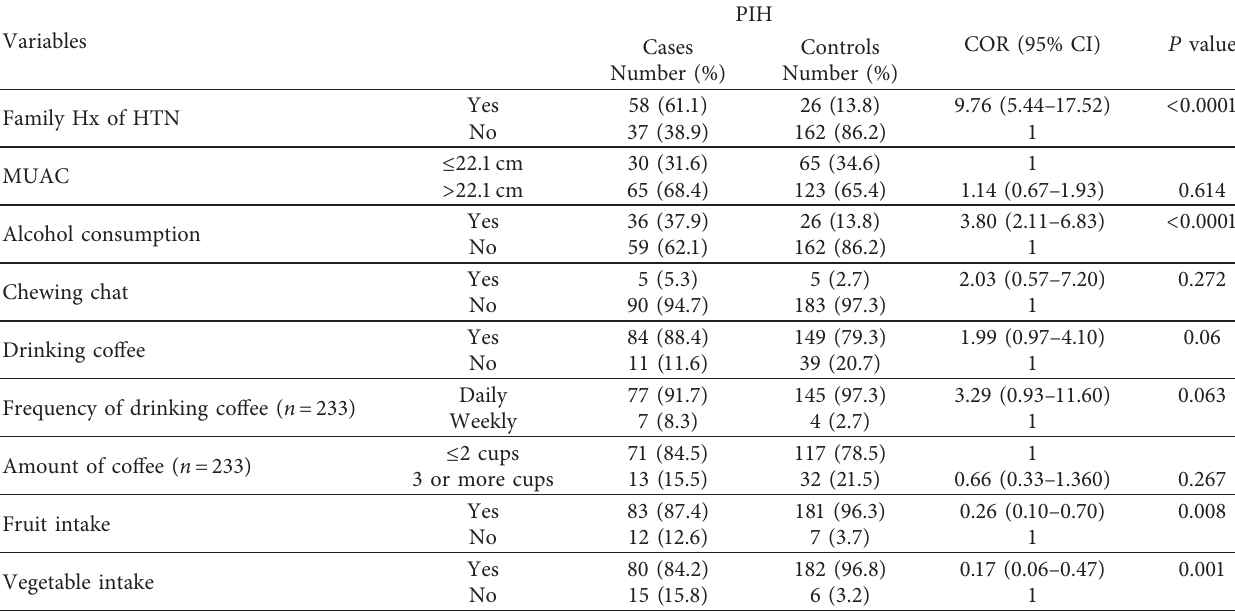
Table 5: Dietary, familial, and lifestyle characteristics of mothers with/without hypertensive disorders of pregnancy in Wolaita zone, southern Ethiopia,